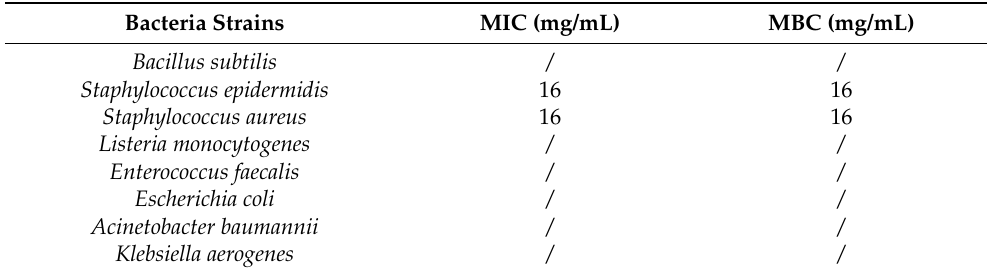
Table 4. Minimum Inhibitory Concentration (MIC) and Minimum Bactericidal Concentration (MBC) of P. spinosa fruit